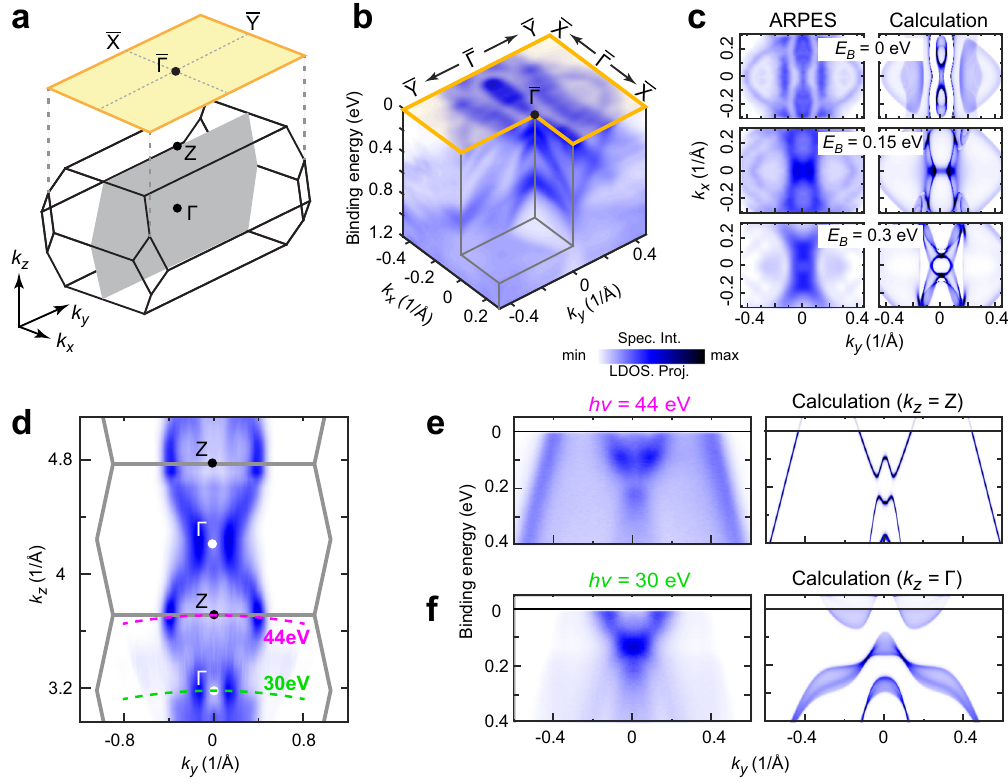
Fig. 2 Overall electronic structures across the 3D Brillouin zone. a Schematic of the bulk (bottom) and (100) surface (top) Brillouin zone (BZ) of 2M- WS 2 with high symmetry points labeled. The gray plane in the bulk BZ indicates the k y – k z measurement plane in d . b 3D intensity plot of photoemission spectra around the (cid:1) Γ point, showing the band dispersions and the resulting FSs. c Comparison showing nice agreement between experiments (left) and ab initio calculations (right) of three constant energy contours at different binding energies. For better comparison with calculations, the experimental plot has been symmetrized with respect to the k y = 0 plane according to the crystal symmetry (same below). d Photoemission intensity plot of the k y – k z plane ( k x = 0, the gray plane in a ), showing clear k z dispersion (and thus the 3D nature) of 2M-WS 2 . Green and magenta curves indicate the k z momentum loci (probed by 30 eV and 44 eV photons, respectively) of the two band dispersions shown in ( e ) and ( f ), respectively. e , f Comparisons between photoemission dispersions (left) and corresponding calculations (right) cutting across high symmetry k z loci (around (cid:1) Γ and Z points, respectively, and k z Integration window around Γ and Z points is 0.06 π /a , where a is the out-of-plane lattice constant) in the bulk BZ as indicated in d